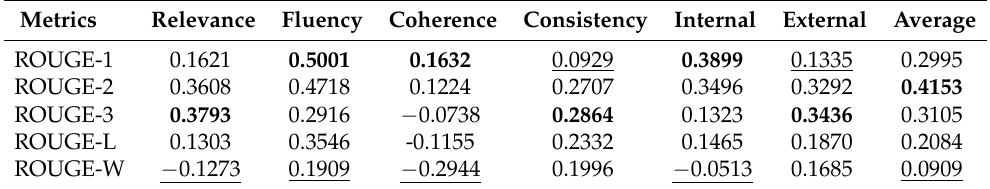
Table 6. Pearson’s correlation of human evaluation scores and ROUGE metrics’ F1-scores of auto- matically generated abstractive summaries. For each human evaluation metric, the most-correlated automatic metric is highlighted in bold , while the less-correlated is underlined.